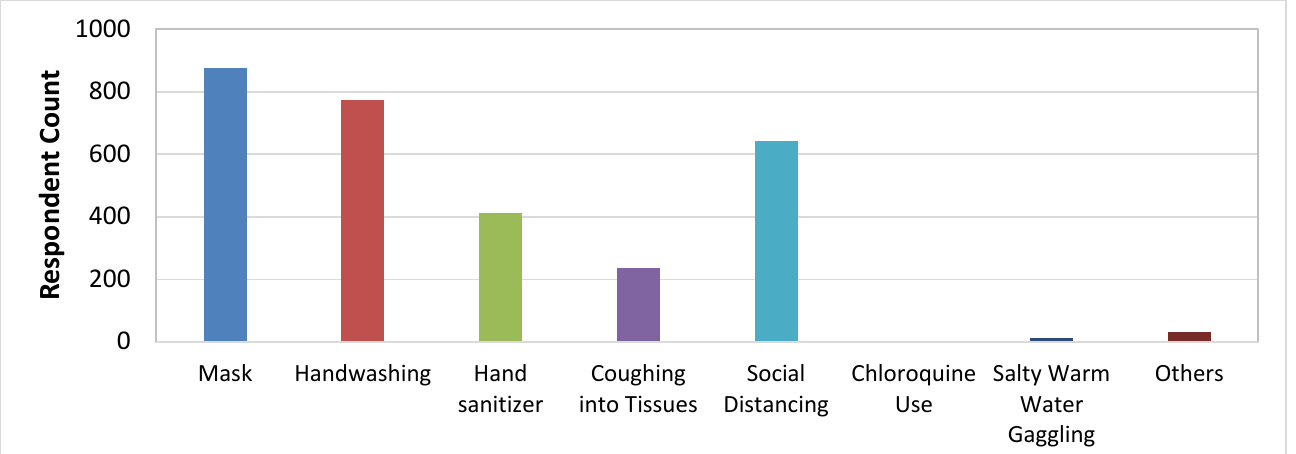
Figure 6. Education distribution of the respondents.